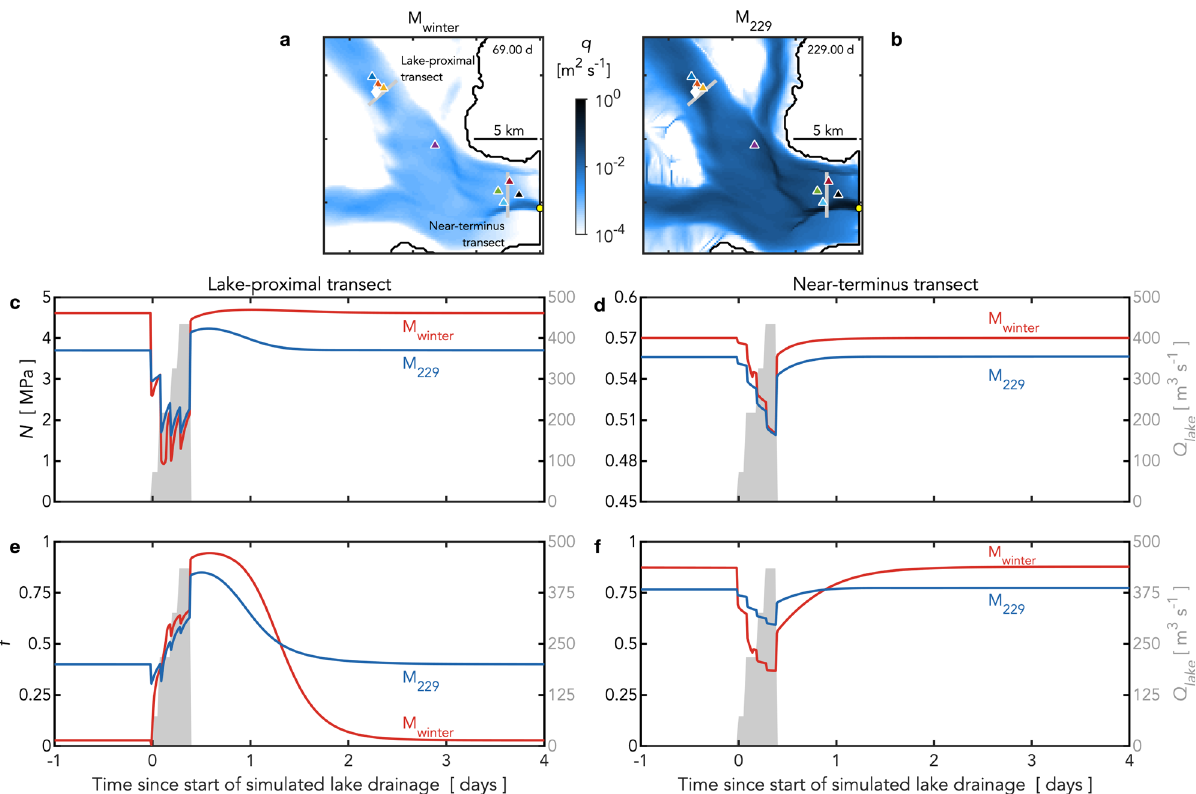
Fig. 4 | Modeled effective pressure and proportion of discharge carried by channels during simulated lake drainages. a Discharge q on 2007/69.00 and (graylines)locationofacross- fl owlake-proximalandnear-terminustransectsinthe model domain. White diamond shows location of simulated lake drainage. Trian- glesshowGPSstationlocations,withstationcolorsasinFigs.1 – 3. b Equivalentplot for 2007/229.00. c (gray shading; right axis) Prescribed lake discharge Q lake and (left axis) modeled effective pressure N across the lake-proximal transect during (red) M winter and (blue) M 229 simulated lake drainages. d Equivalent plot for the